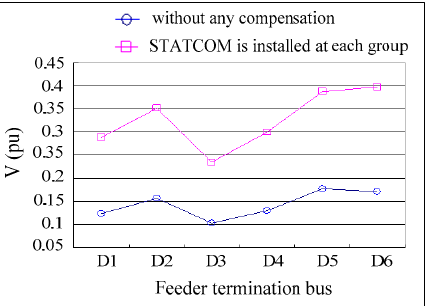
Figure 16. Comparison of the generator voltage with a STATCOM installed at the feeder termination bus D1 – D6 of each group.